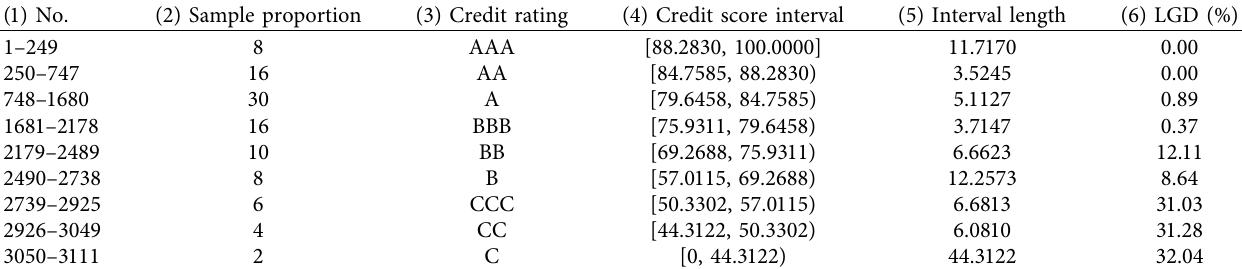
Table 6: Credit rating results based on customer number distribution.